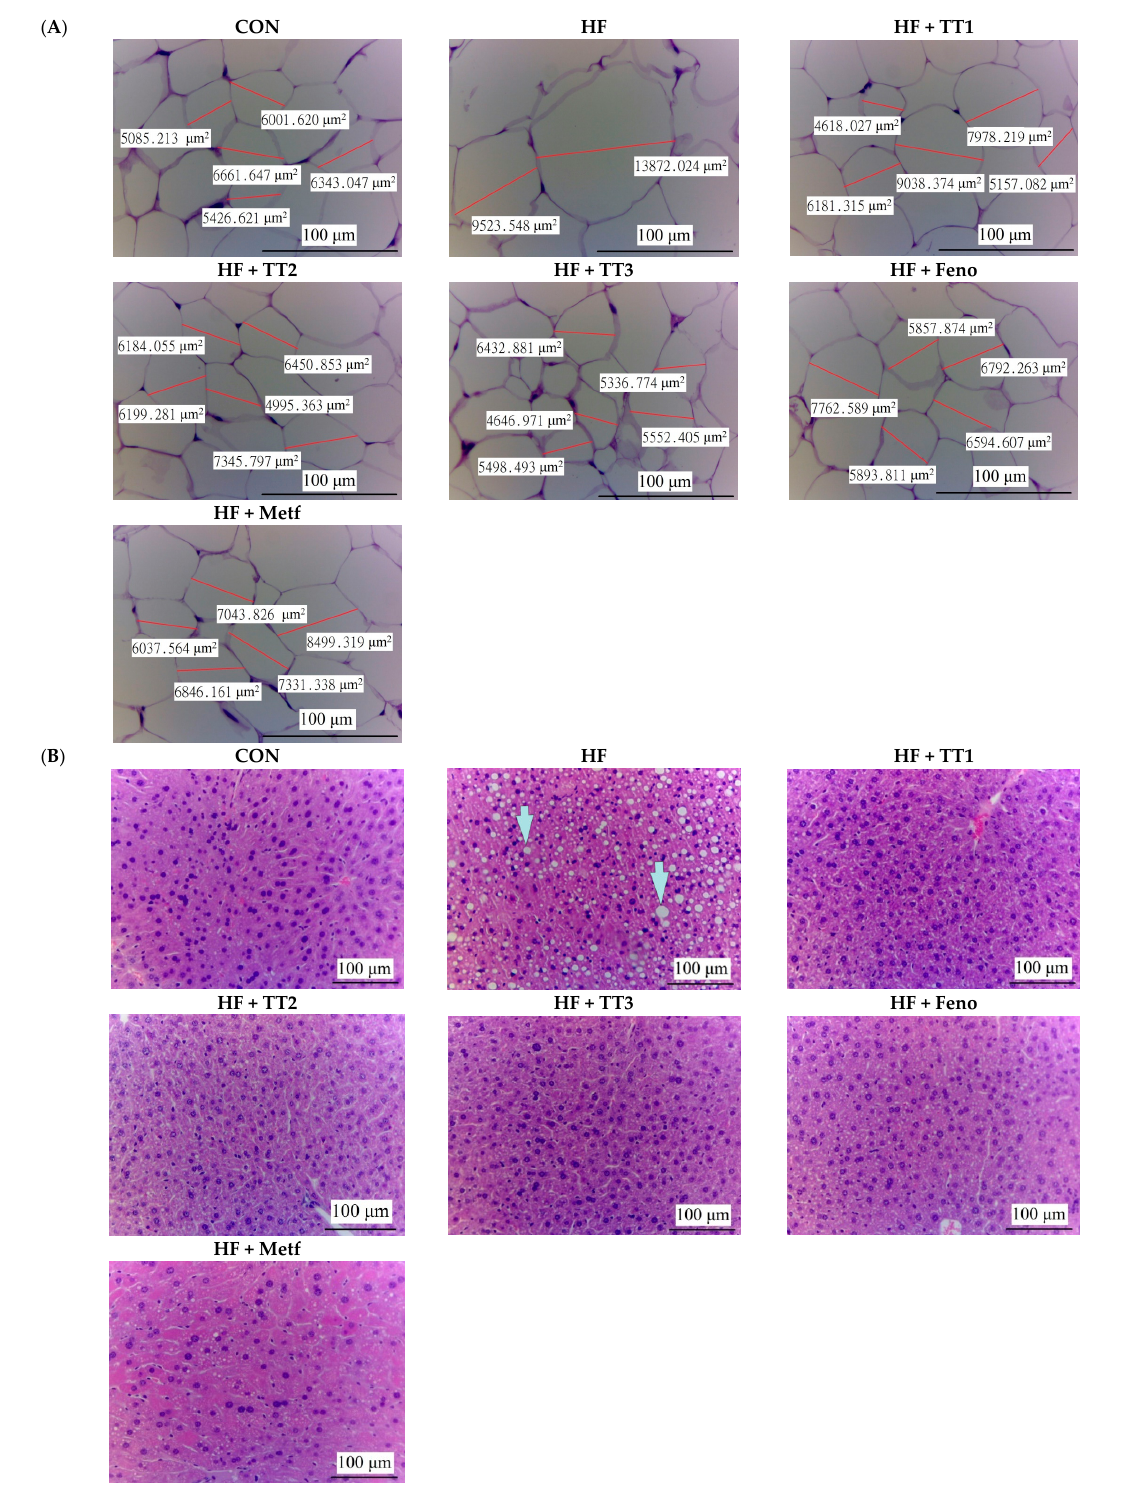
Figure 3. Pathological effects of dehydroeburicoic acid (TT) on ( A ) epididymal white adipose tissue (WAT); and ( B ) liver tissue of mice in the control (CON), high-fat-diet plus vehicle (distilled water) (HF), HF+ TT1, HF + TT2, HF + TT3, HF + Fenofibrate (Feno), or HF + metformin (Metf) groups by hematoxylin and eosin-staining. Magnification: 10 (ocular) × 20 (object lens). TT1, TT2, and TT3: dehydroeburicoic acid (TT1: 10, TT2: 20, and TT3: 40 mg/kg bodyweight); Feno: fenofibrate (250 mg/kg body weight), Metf: metformin (300 mg/kg body weight).